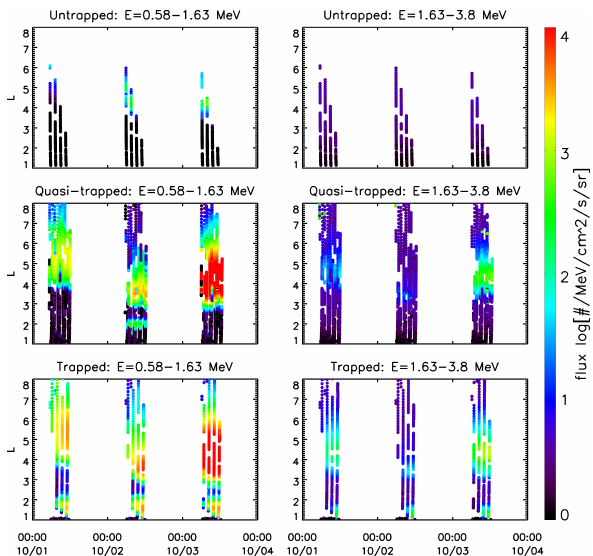
Figure 9. Flux variations of three electron populations (from top to bottom: untrapped, quasi-trapped, and trapped) measured by REPTile onboard CSWWE for the energy channels of (left) 0.58– 1.63MeV and (right) 1.63–3.8MeV during the 3-day period. The color scale specifies the logarithmic values of electron fluxes.The large data gaps are due to limited duty cycle of REPTile during this time